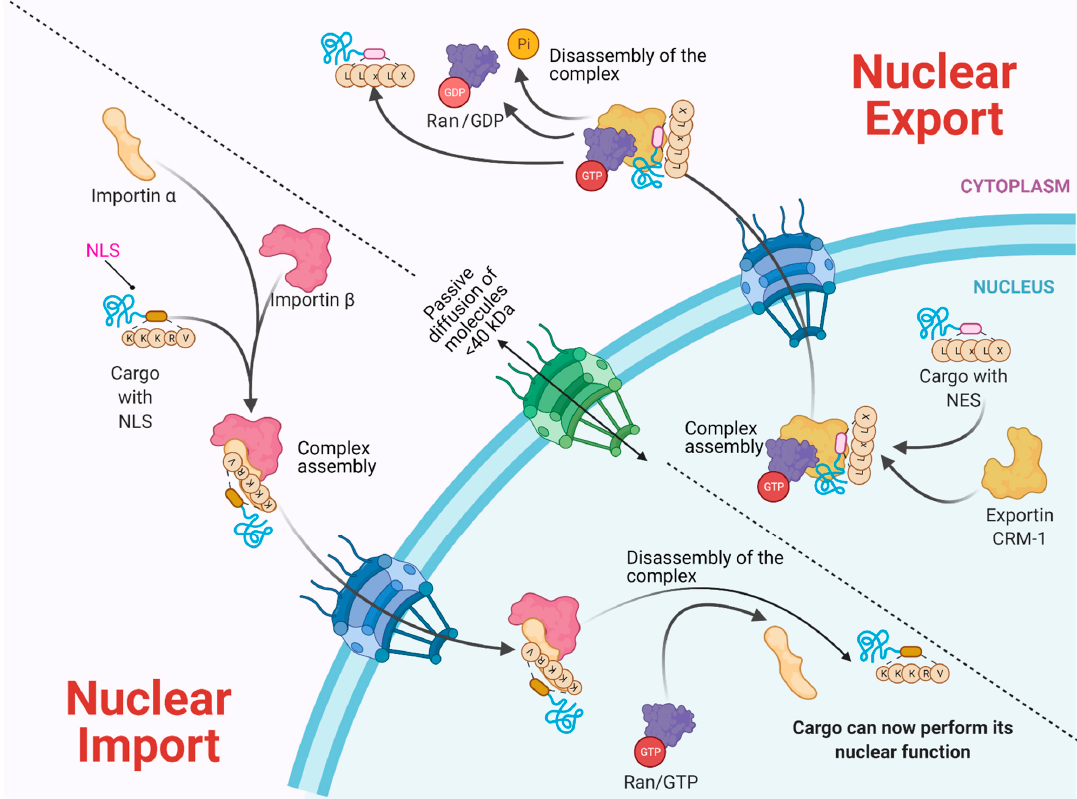
Figure 2. Bidirectional Nucleus–cytoplasm Transport. In the classical pathway of import (importin α / β ), the importins and cargo complex are formed through the recognition of the NLS (nuclear location sequence). In the case of Export via CRM-1, the charge contains an NES (nuclear export sequence). In both cases, a GTP gradient is required. Molecules <40 kDa pass through passive diffusion towards the nucleus by the NPC.